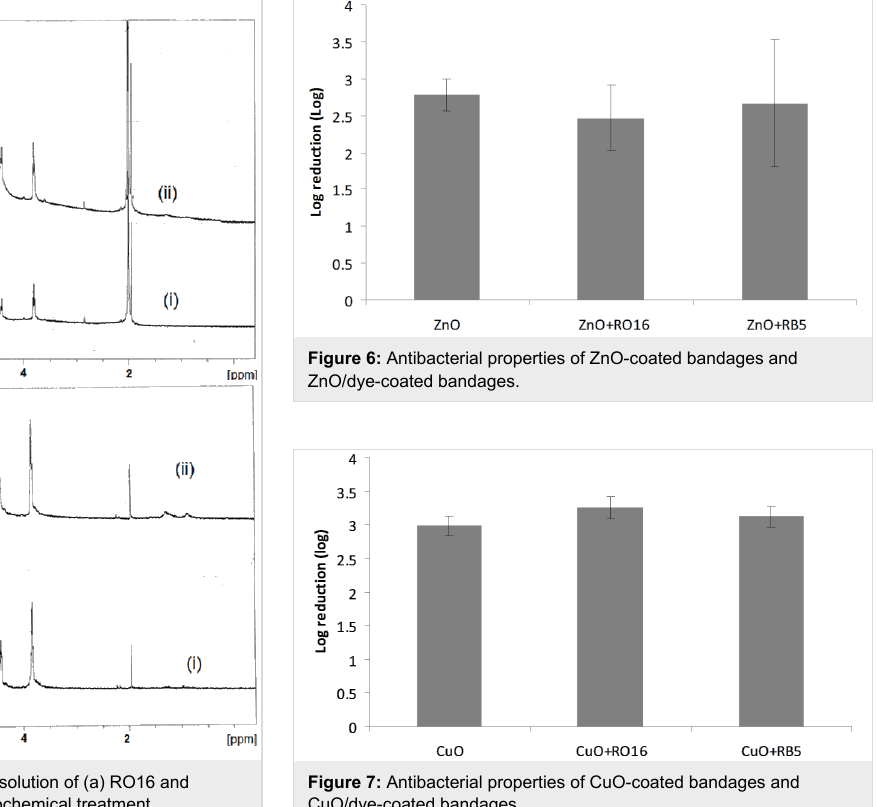
ICP-OES measurements. The second column in Table 2